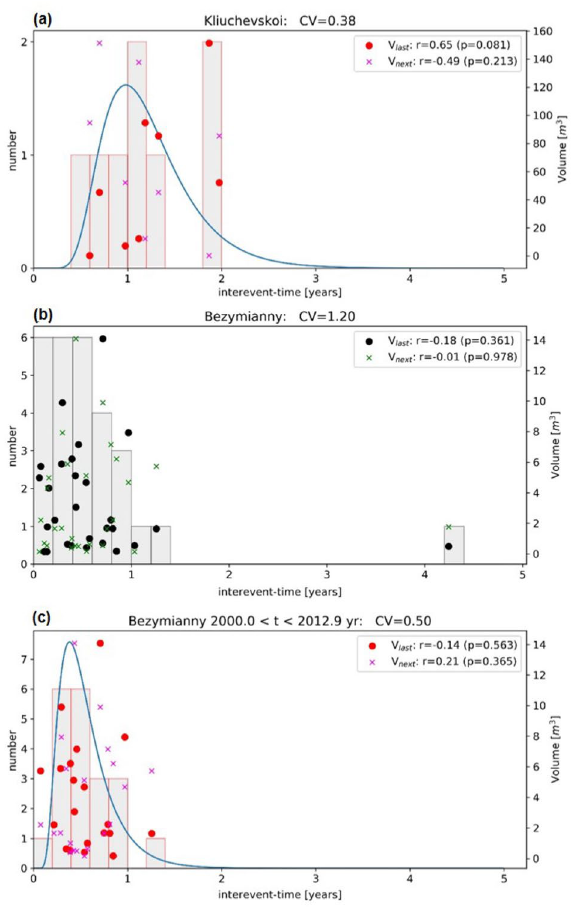
Figure 4. Inter-eruption times distribution (bars) for ( a ) Klyuchevskoy, ( b ) Bezymianny—whole period (2000– 2020), ( c ) Bezymianny—pre-Tolbachik eruption (2000–2012). The coefficient of variation (CV), a measure for the eruption’s periodicity, is provided in the title of each plot. Symbols show the eruption volume (right axis) in all three panels as a function of the inter-eruption time, where points and crosses refer to the volume of the last and next event, respectively. The correlation coefficient (r) between volume and interevent-time with its p value is provided in the